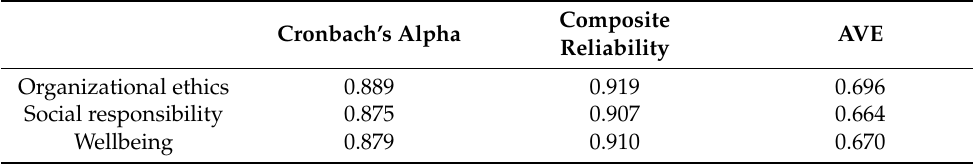
Figure 4. Model applied. Source: designed by authors using SmartPLS 3.0 (SmartPLS GmbH, Oststeinbek, Germany).